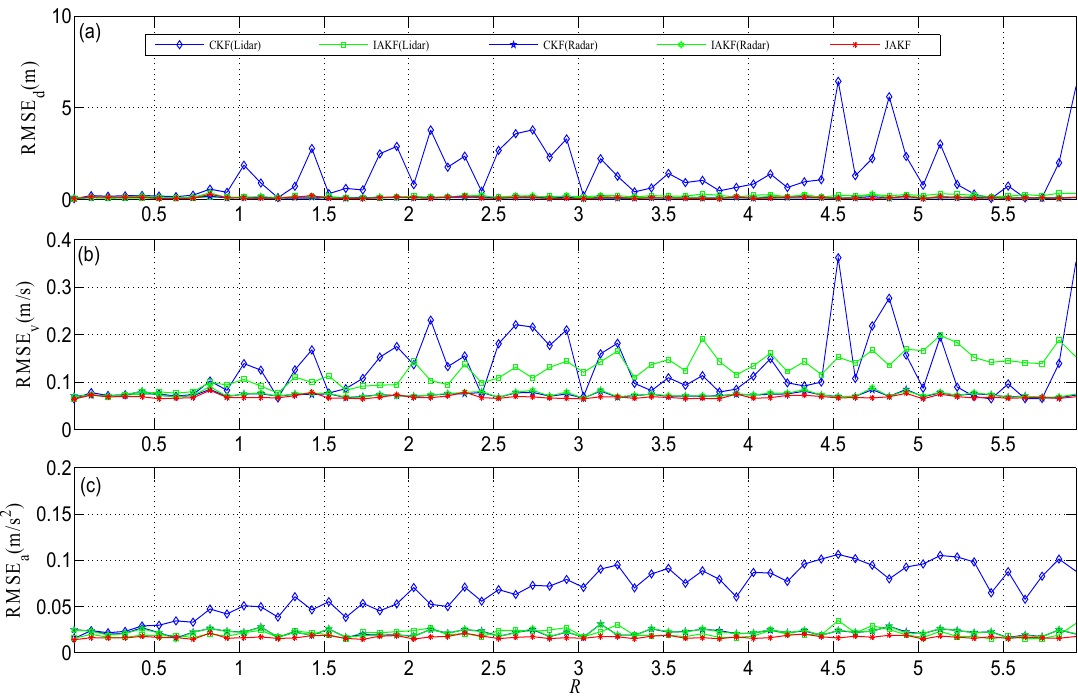
Figure 3. Comparisons of motion state estimation against different noise variances R : ( a ) The displacement estimation; ( b ) The velocity estimation; ( c ) The acceleration estimation.